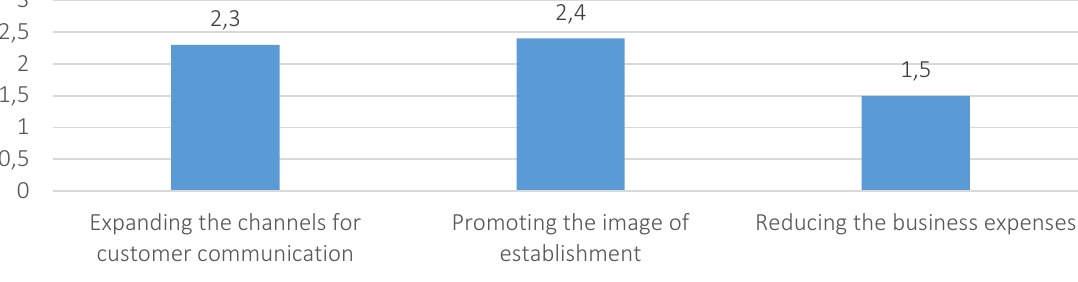
Figure 2. Efficiency of digital marketing application by handicraft